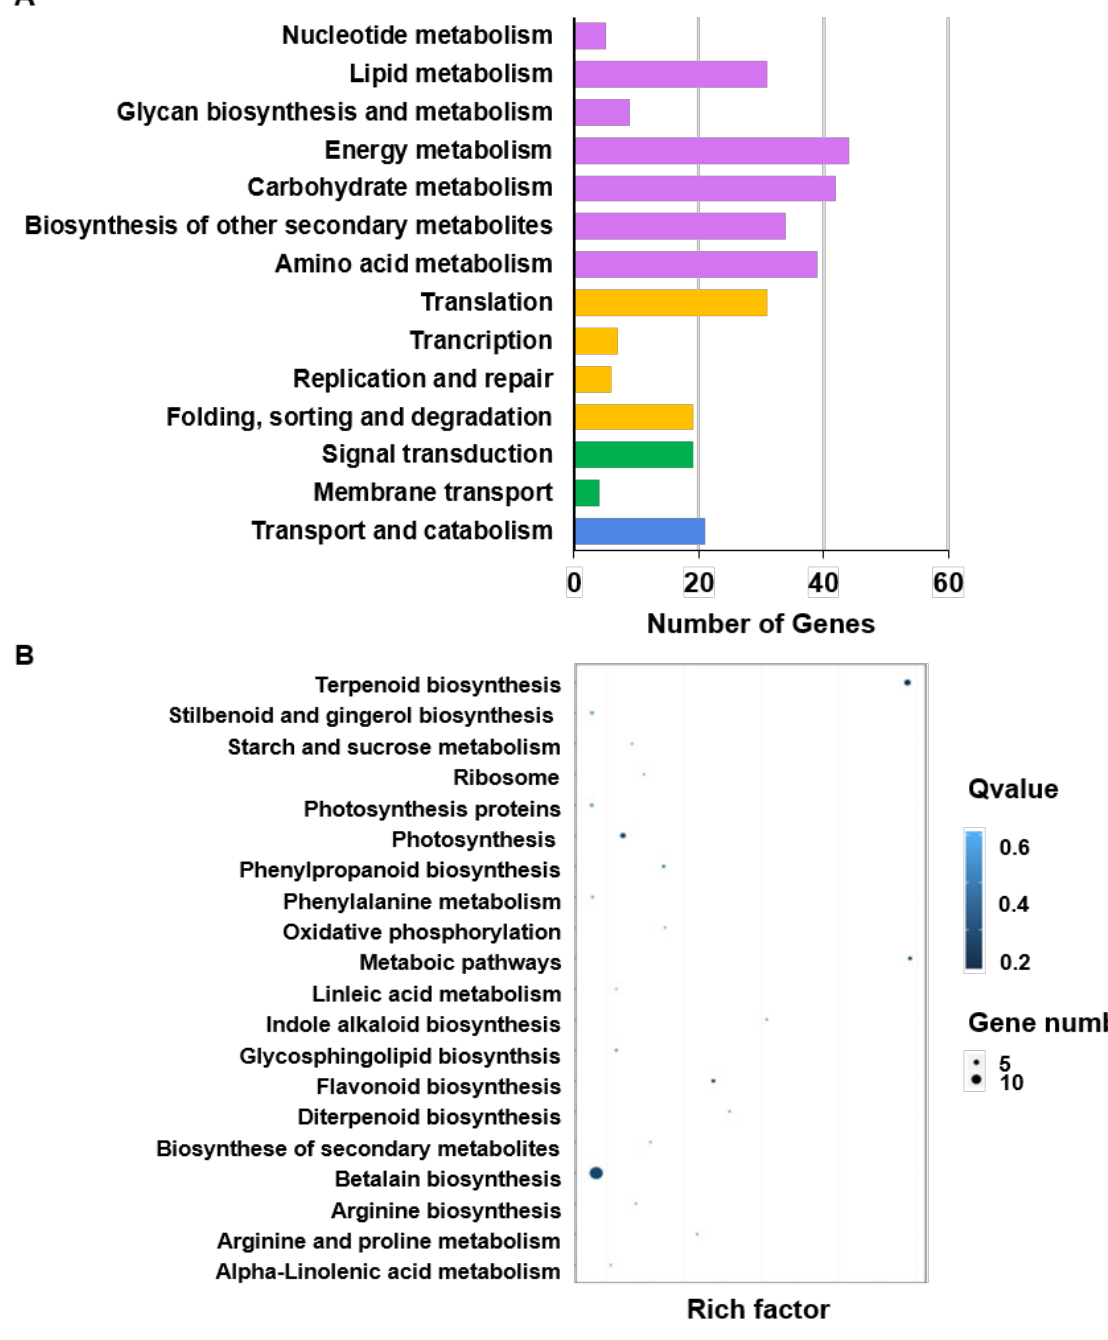
Figure 9. KEGG pathway enrichment analysis of DEGs: ( A ) Number of genes; and ( B ) the y -axis indicates the enriched pathways, while the x -axis indicates the rich factor, which refers to the ratio of the number of DEGs enriched in a certain KEGG pathway to the number of annotated genes. The greater the value, the higher the DEGs enrichment degree. Color indicates q-value and size indicates the DEG count. The chart shows the 20 most-enriched pathways. Note: NT, normal growth condition under 25/18 ◦ C and water; NS, normal growth condition under 25/18 ◦ C with 1 mM Spd treatment on plants; HT, high temperature growth condition on 38/28 ◦ C and water treatment; HS, high temperature growth condition on 38/28 ◦ C with 1 mM Spd treatment on leaves.